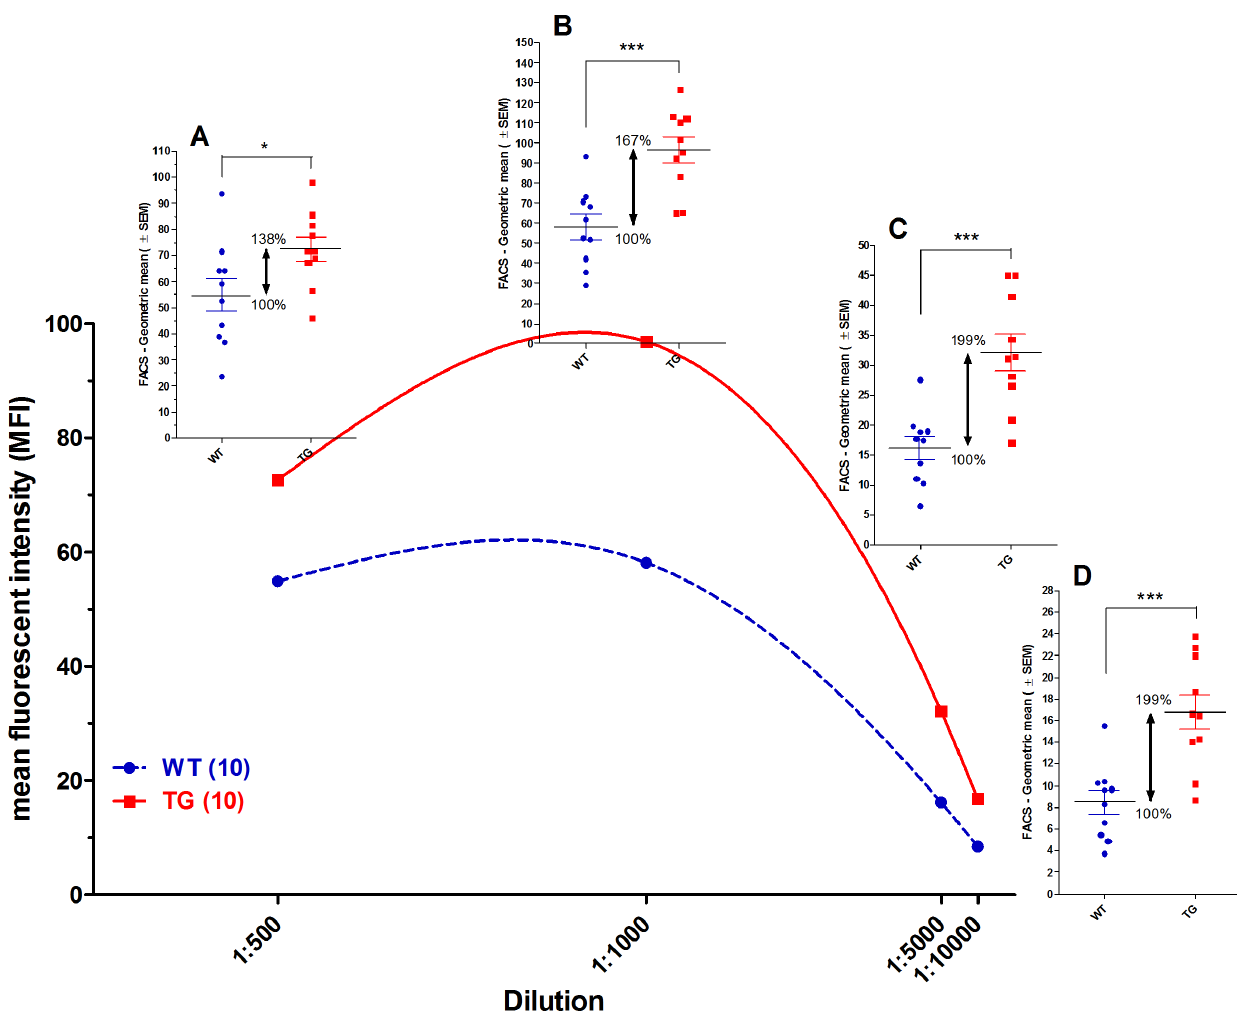
Figure 2. Binding of rATG to Jurkat cells from serum samples at different dilutions. Flow cytometry binding assay was performed and the geometric means of fluorescence intensities obtained are presented for different immune sera dilutions. Antigen binding of individual samples at immune serum dilutions of 1:500 ( A ), 1:1000 ( B ), 1:5000 ( C ) and 1:10000 ( D ) are shown in small inserts. Data show that Tg sera bindings were significantly higher than its wt controls in all dilutions. Each dot represents one animal as an average of three measurements (* P , 0.05; *** P ,